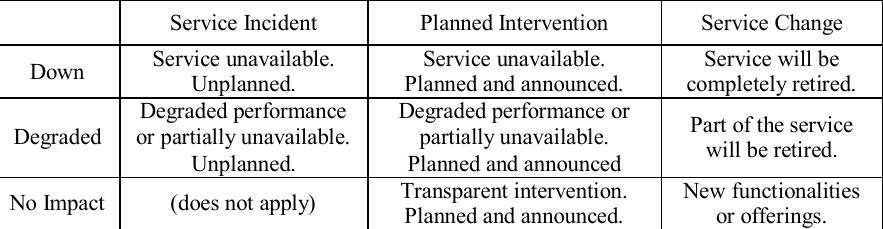
Service will be completely retired. Part of the service will be retired. New functionalities or